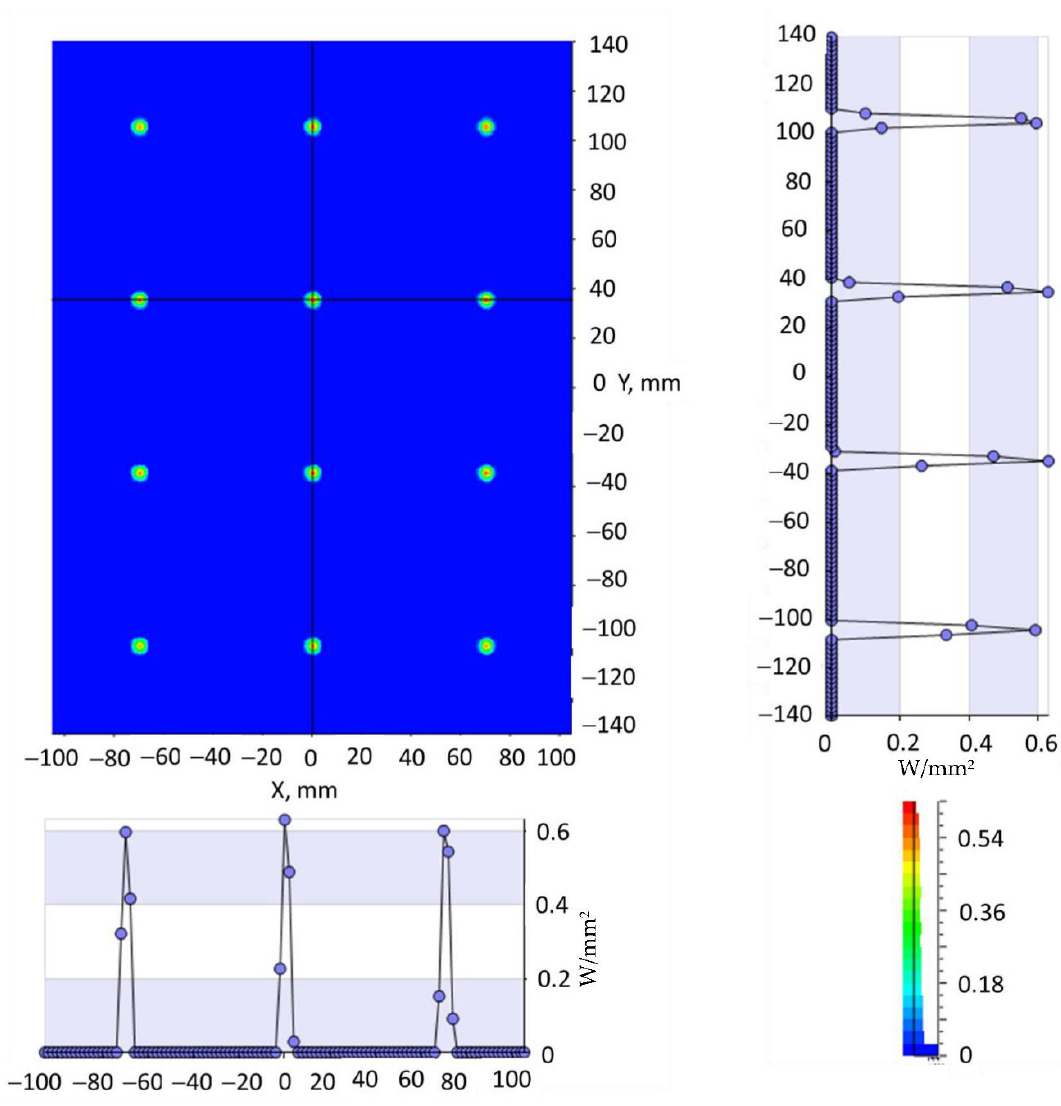
Figure 11. An array of such dual-lens concentrator units forms a set of equidistant focusing points, provisionally fulfilling the target of a primary concentrator at this